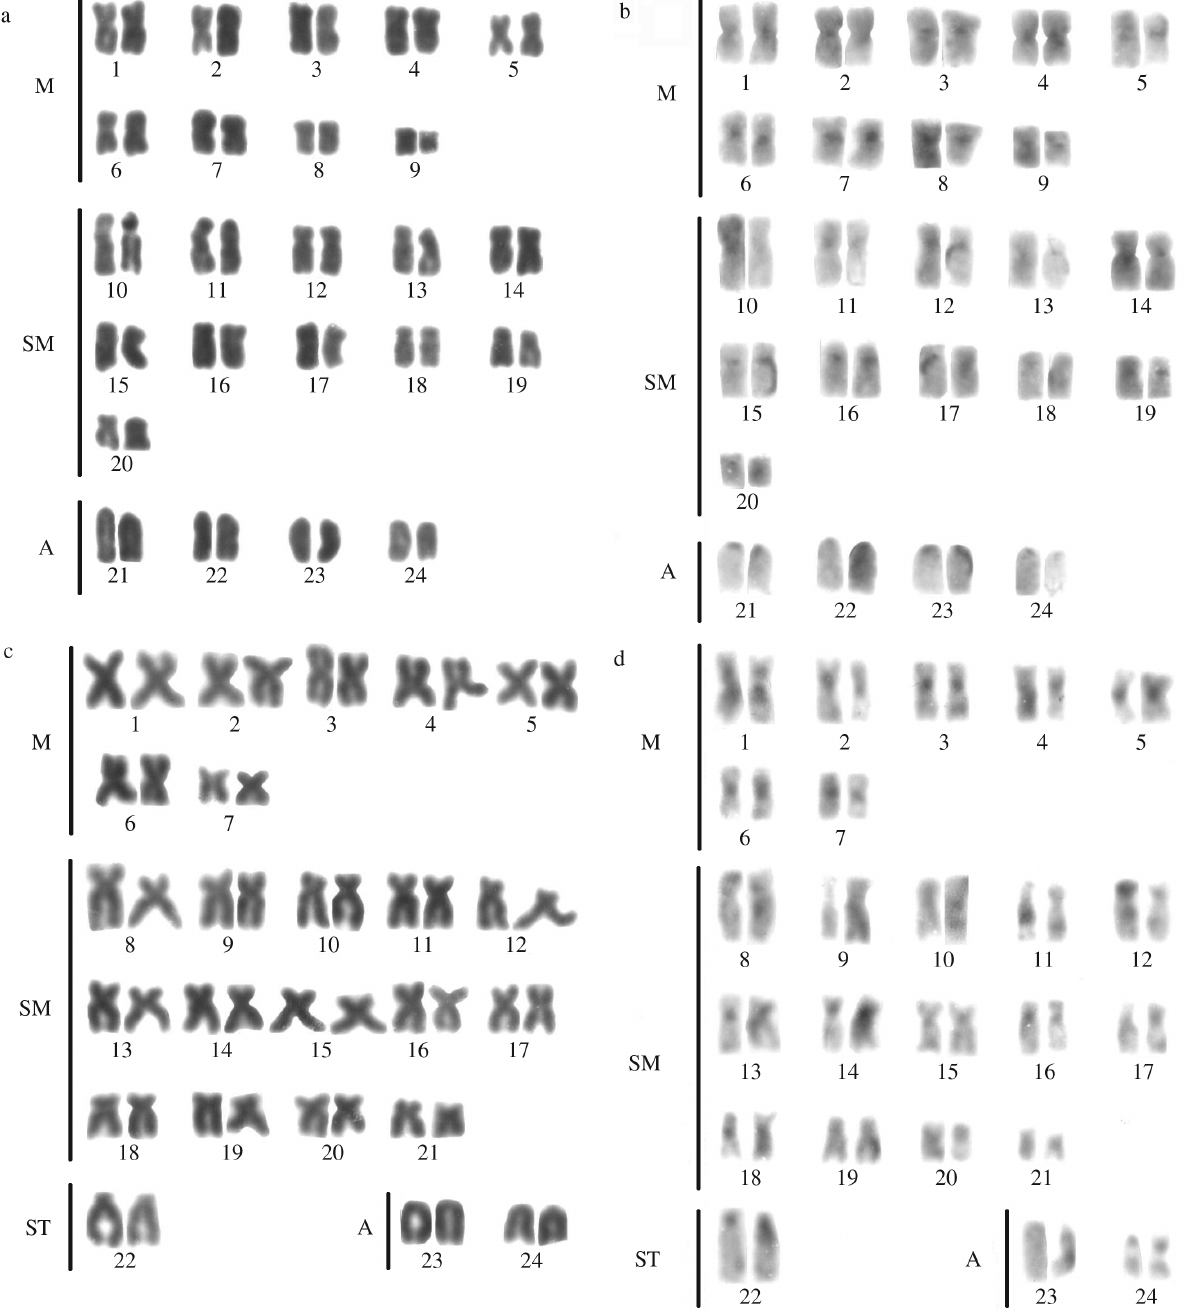
Figure 2 - Karyotypes stained by Giemsa and C banding patterns in (a, b) S. leucostictus (2n = 48, FN = 88) and (c, d) S. pictus (2n = 48, FN = 92). The NOR-bearing chromosomes are located in the tenth and eighth pairs,